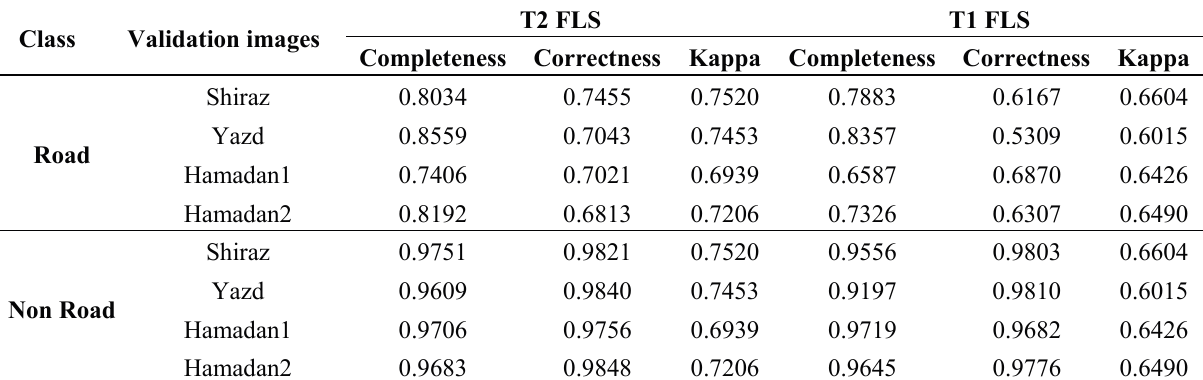
Table 8. Validation result of T1 and T2 FLSs after